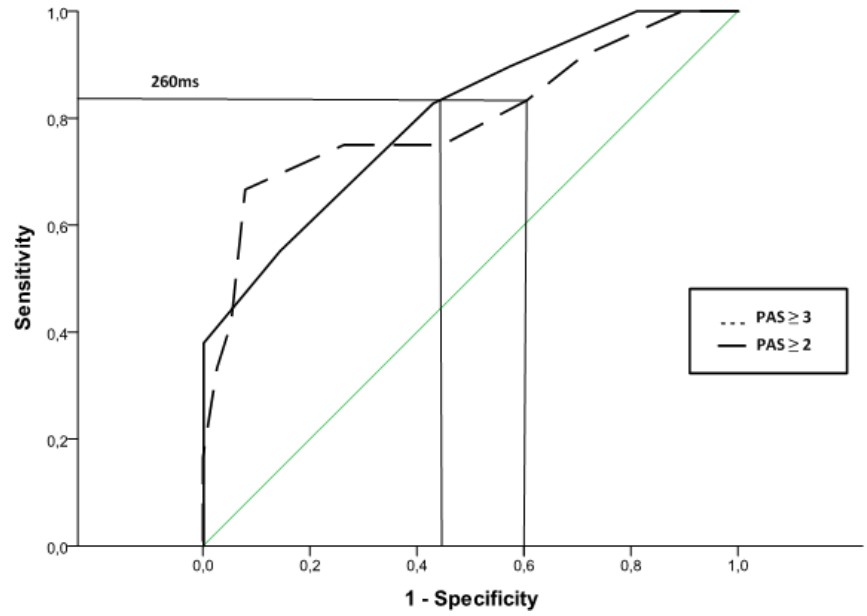
Figure 3. Receiver-operator characteristic (ROC) curve showing LVC time sensitivity/specificity for unsafe swallow (PAS ≥ 2 and PAS ≥ 3) of 5 mL of a 120 mPa·s bolus. Depicted is the cut-off value of 260 ms.